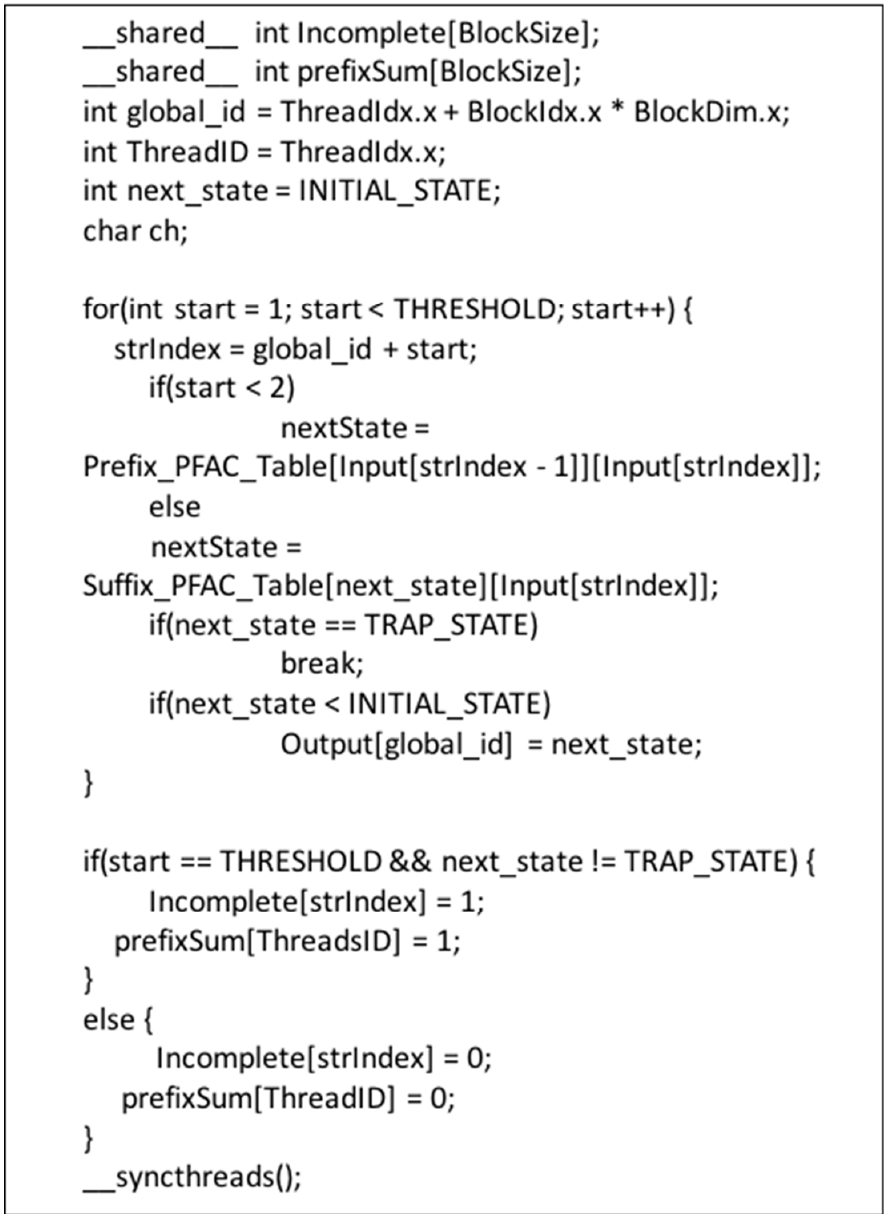
Figure 5. Phase one of the two-phase PFAC algorithm: Initial state traversal.